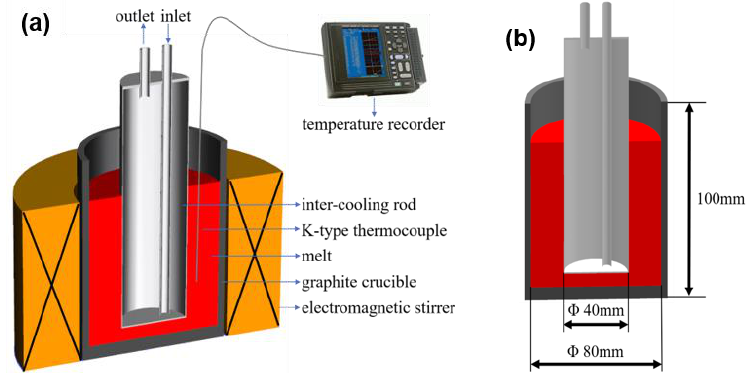
Figure 1. (a) Schematic view of the melt treatment apparatus by IC-AEMS, (b) the experimental Figure 1. ( a ) Schematic view of the melt treatment apparatus by IC-AEMS, ( b ) the experimental dimensions of the graphite crucible and the inter-cooling rod. dimensions of the graphite crucible and the inter-cooling rod.